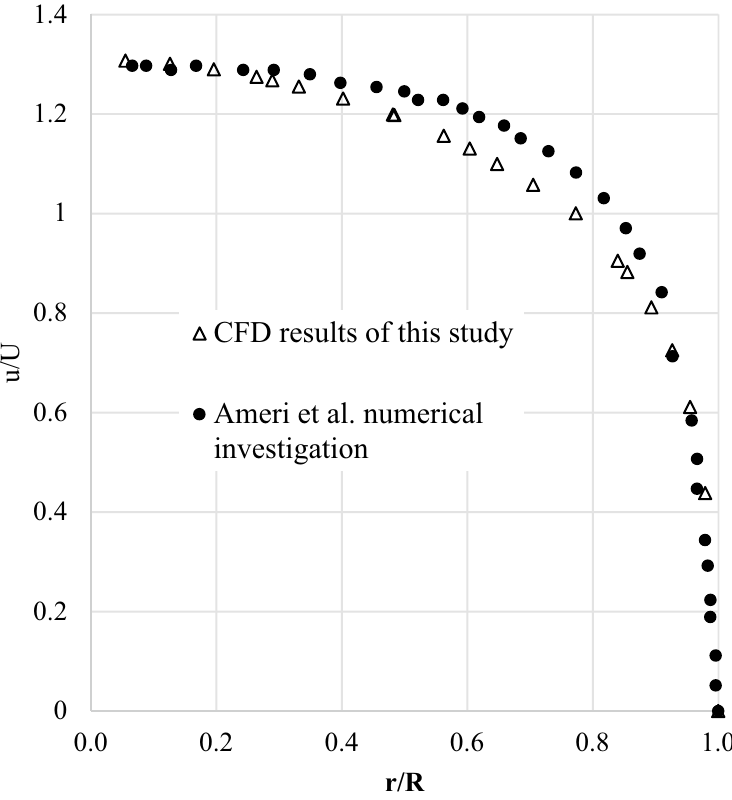
Figure 1. Comparison of velocity profile predicted by CFD from this study and that from Ameri et al. 26